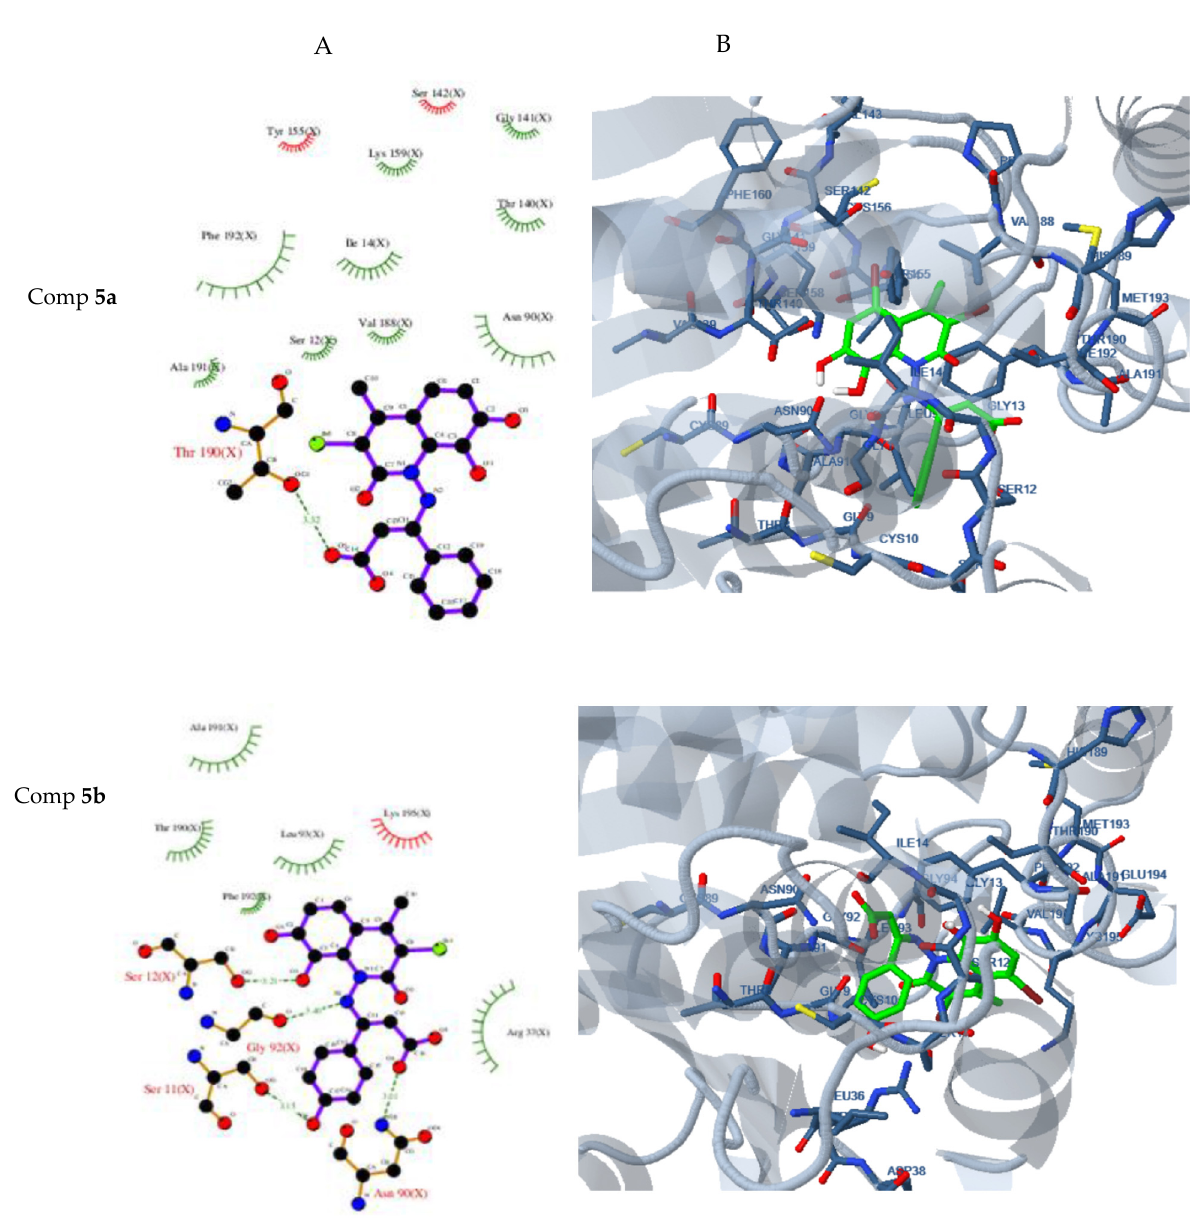
Figure 6. Interaction of docked compounds 5a and 5b inside the binding site of (3HB5). ( A ) 2D interaction; ( B ) 3D interaction.